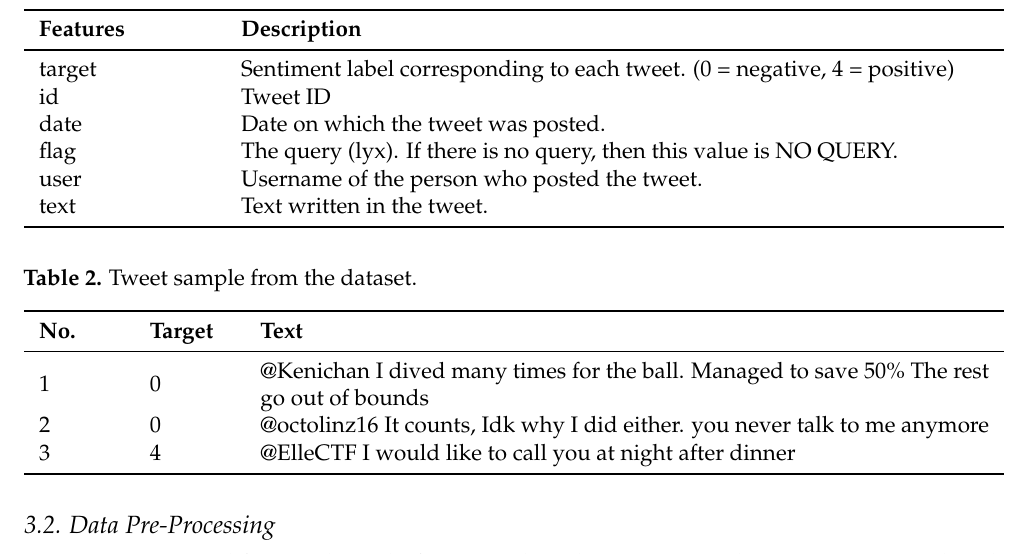
Table 1. Dataset Description.